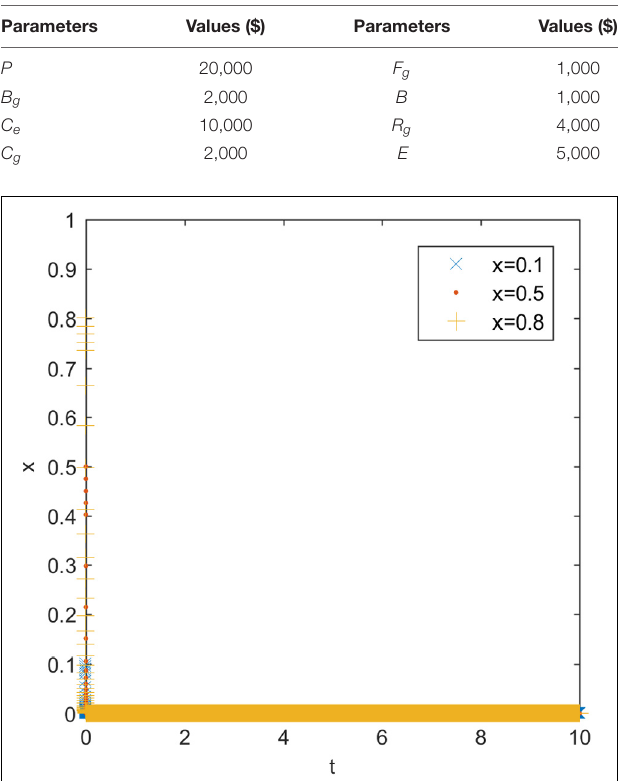
TABLE 9 | The parameter settings.